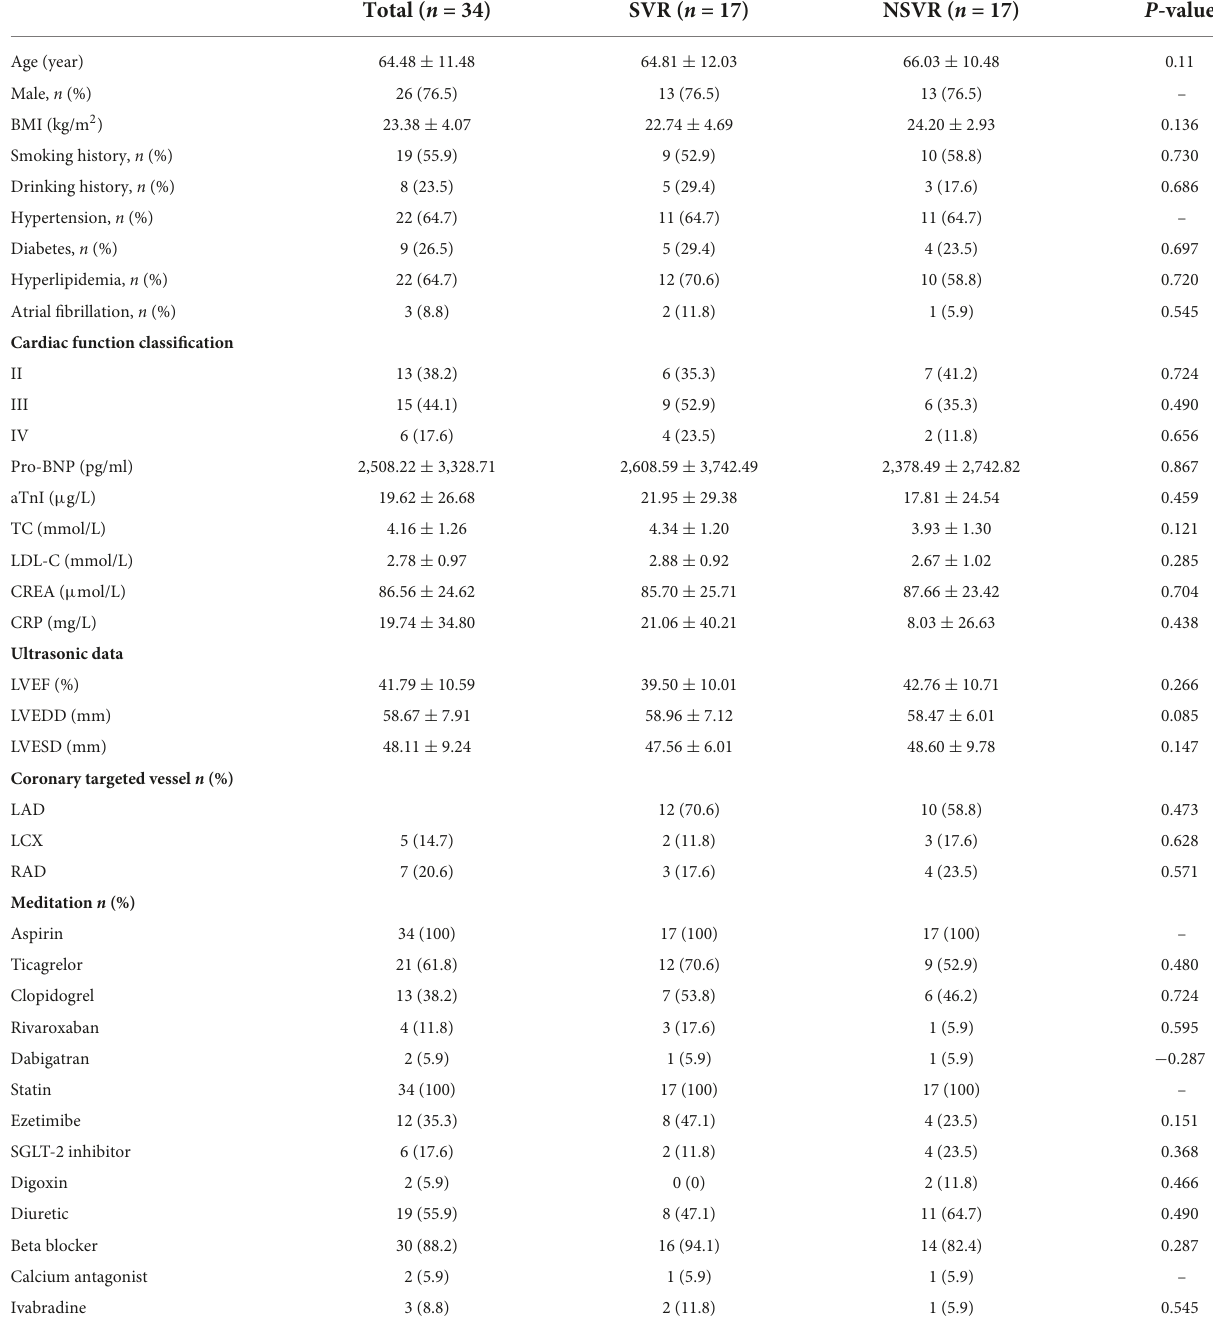
TABLE 3 The clinical characteristics of SVR and NSVR patients in the tsRNA validation